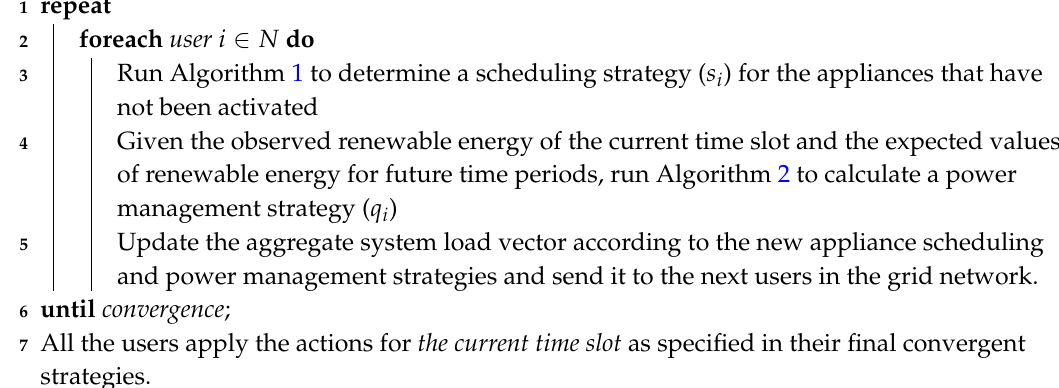
Algorithm 3: Distributed demand-side management (DDSM) algorithm (executed at the beginning of each time